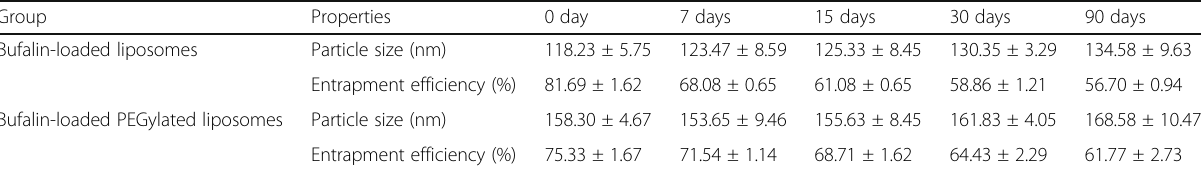
Table 1 Particle size and entrapment efficiency of bufalin-loaded liposomes and bufalin-loaded PEGylated liposomes in the stability